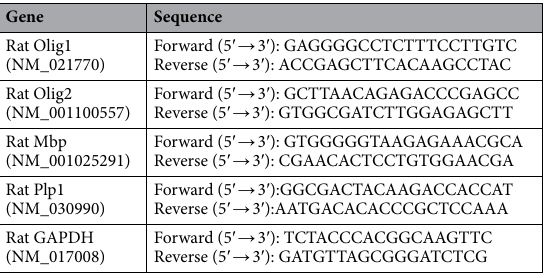
Table 1. The specific primer sequences for